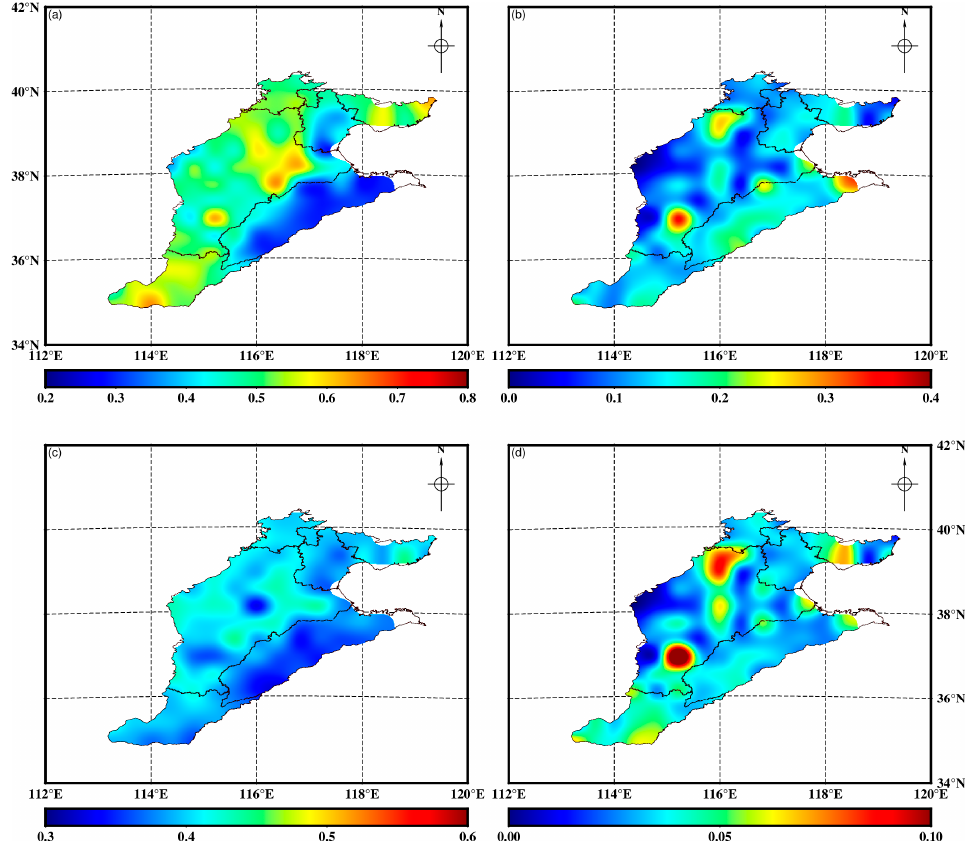
Figure 4. Different performance indices derived from monitoring well observations for the period of 2005–2018: ( a ) reliability (Rel), ( b ) resilience (Res), ( c ) vulnerability (Vul), and ( d ) sustainability index (Si).